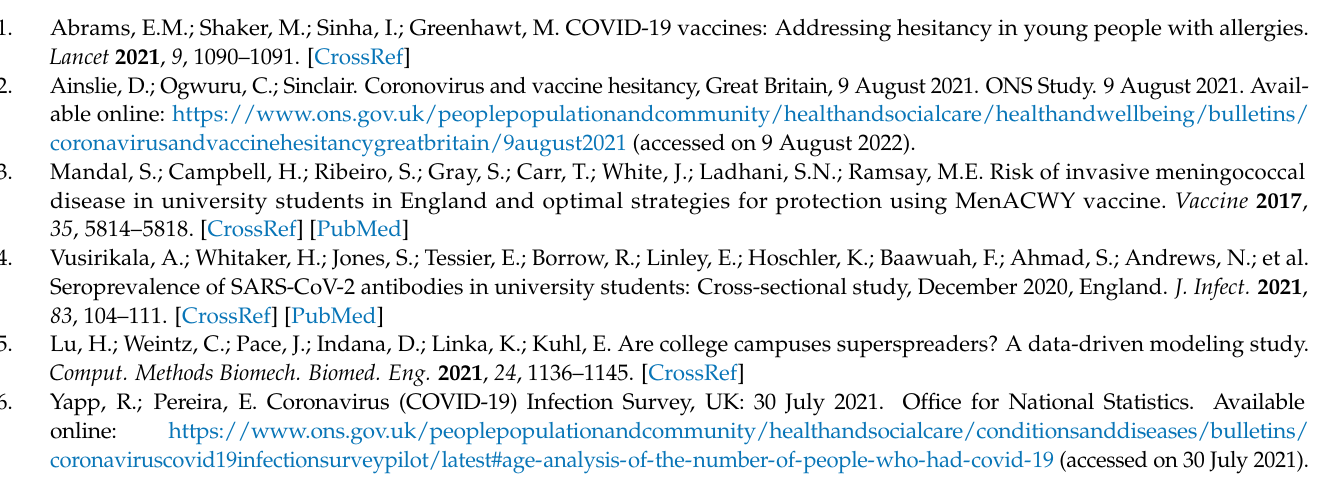
Table S1: UniCoVac Questionnaire; Table S2: Weighting values for the weighted multivariate analysis; Table S3: Comparison of ethnicity demographics of UniCoVac questionnaire participants to University of Leicester and UK universities; Table S4: Comparison of gender demographics of UniCoVac questionnaire participants to University of Leicester and UK universities; Table S5: Comparison of demographics for Year groups between UniCoVac questionnaire participants and University of Leicester undergraduate population; Table S6: Classification of questionnaire respondents for vaccine hesitancy (dichotomous); Table S7: Univariable analysis of attitudes to on campus delivery of MMR and MenACWY vaccines; Table S8: Multivariate analysis of attitudes to on campus delivery of MMR and MenACWY vaccines; Table S9: Reasons for hesitancy of vaccine-hesitant